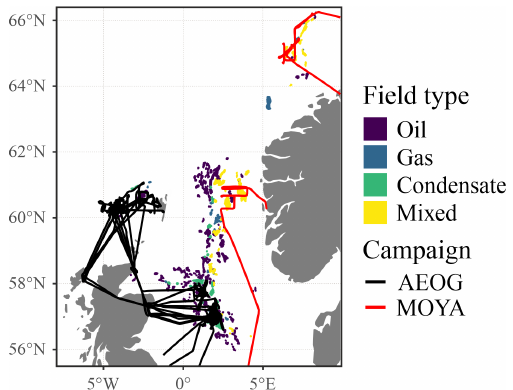
Figure 1. AEOG (black) and MOYA (red) flight paths in the North and Norwegian seas. Coloured data points indicate the locations of different hydrocarbon field types (see Wilde et al., 2021, or Foulds et al., 2022, for detail). Note that the northernmost flight ( ∼ 65 ◦ N) took place over the Norwegian Sea and not the North Sea. However, for the purposes of simplicity here, all sample regions are referred to as the North